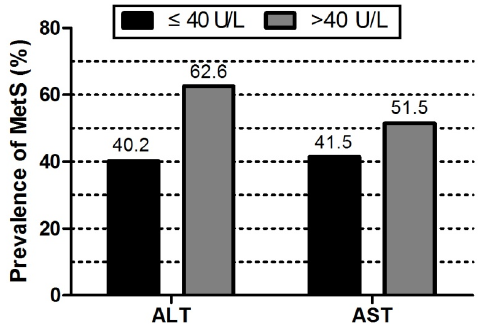
Figure 1. Comparison of the prevalence of metabolic syndrom in both groups of ALT/AST < 40 U/L and ALT/AST > 40 U/L.